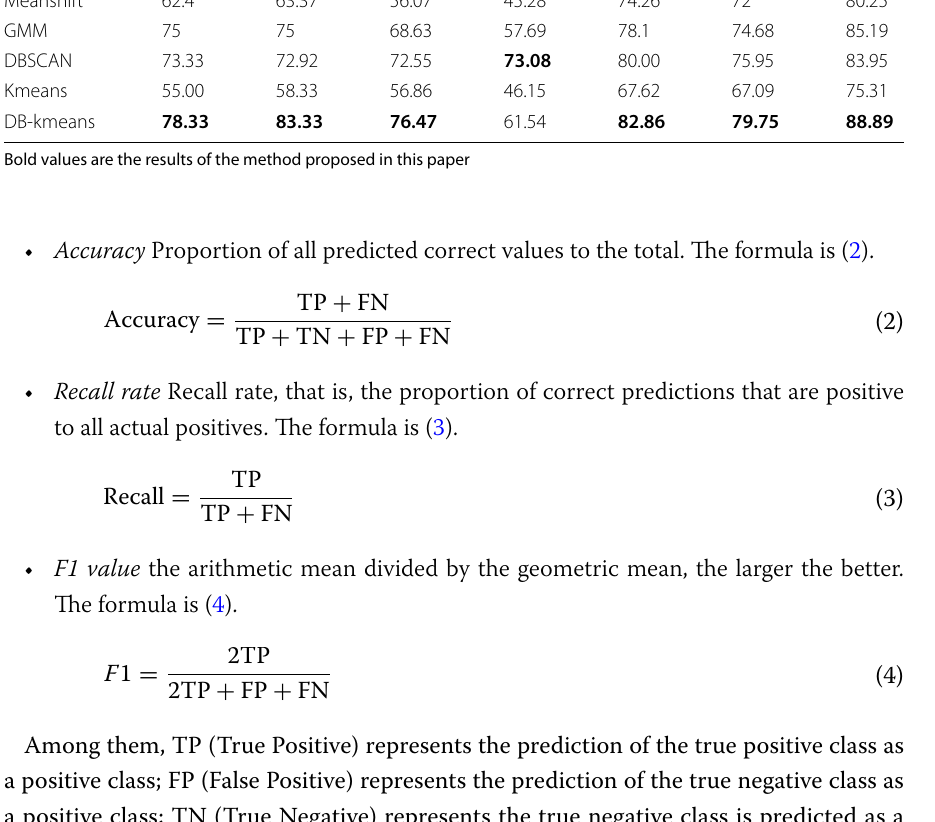
Bold values are the results of the method proposed in this paper Table 4 Recall of each cluster #